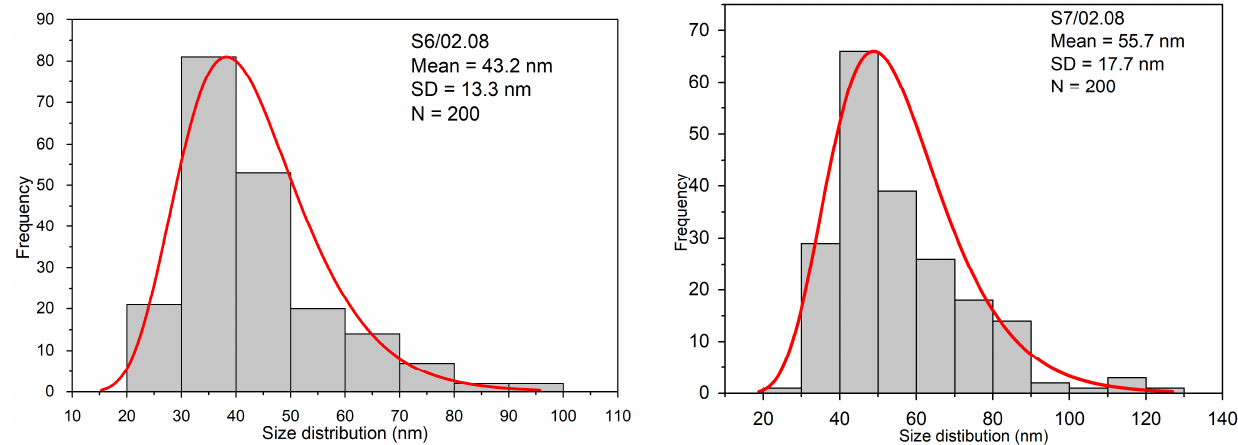
Figure 4. The size distribution of AuNPs for S6/02.08 ( left ) and S7/02.08 ( right ). The histogram was best fitted with the Gauss function. The highest percentage of S6/02.08 NPs were found to be within the 30–50 nm diameter size range having a mean diameter of 43.2 ± 13.3 nm and S7/02.08 NPs were found to be within the 40–60 nm diameter size range having a mean diameter 55.7 ± 17.7 nm.